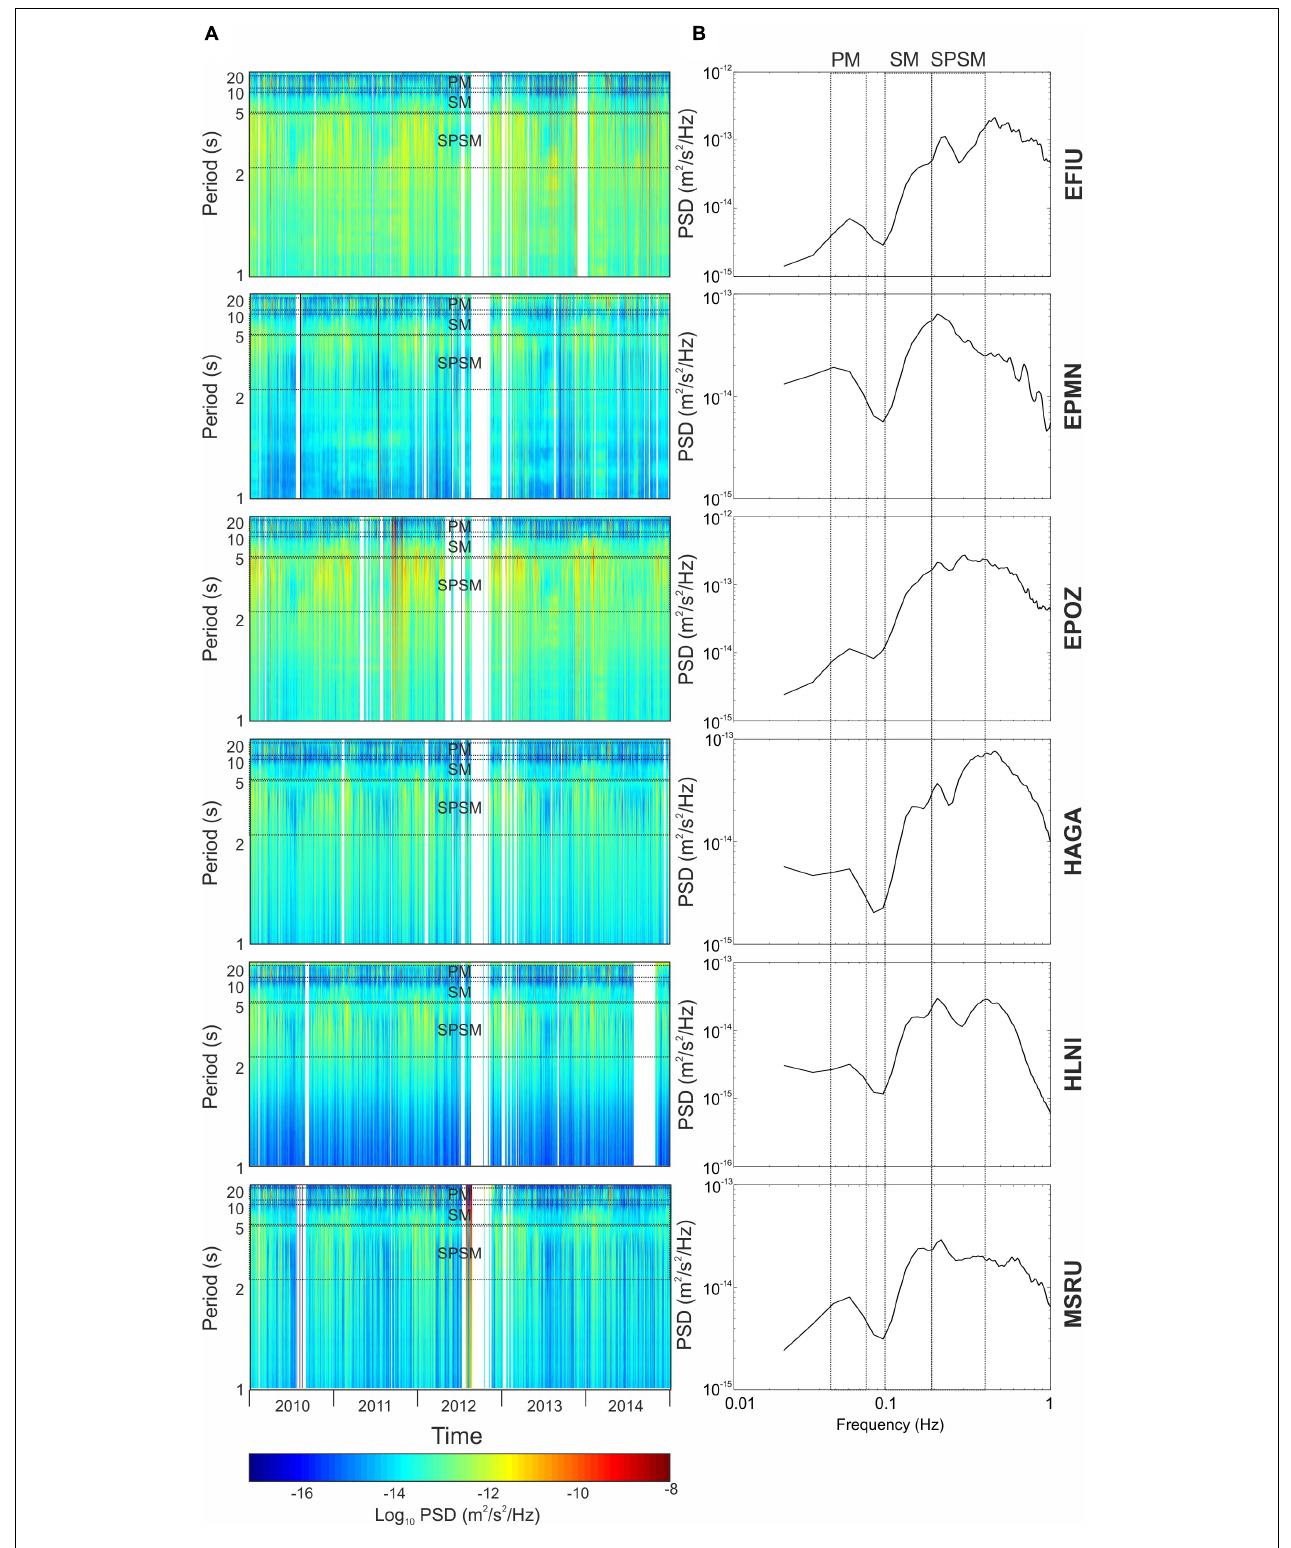
FIGURE 3 | (A) Spectrograms of the seismic signal recorded by the vertical component of the six considered stations. (B) Median spectra of the seismic signal recorded by the vertical component of the six considered stations. The acronyms PM , SM , and SPSM indicate primary microseism, secondary microseism, and short-period secondary microseism,